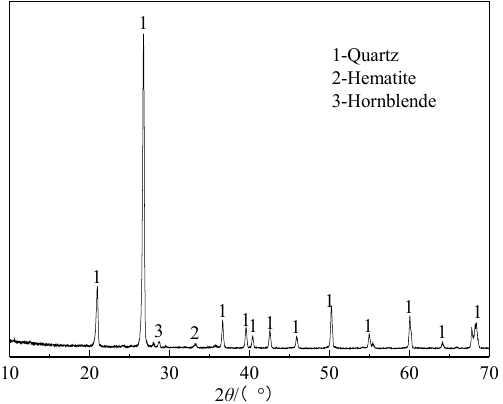
Figure 5. XRD pattern of the high-silica residues.